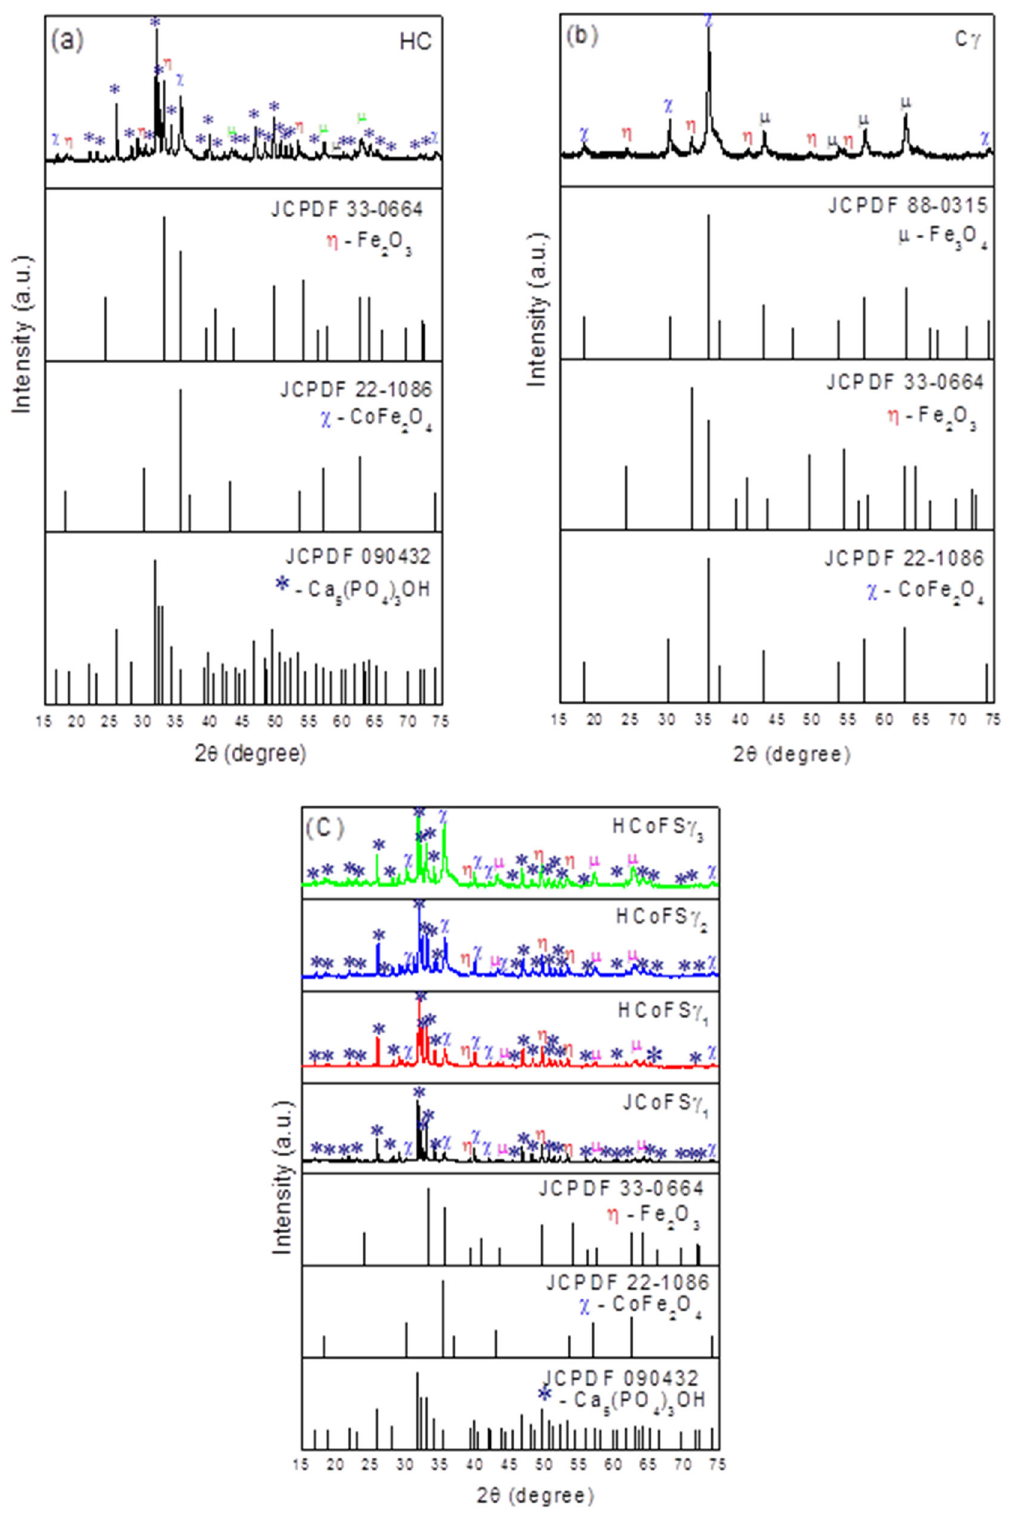
Fig. 1 X-ray diffraction (XRD) of the hybrid composites: ( a ) CoFe 2 O 4 @SiO 2 :HAp (HC); ( b ) CoFe 2 O 4 @SiO 2 : γ (C γ ); ( c ) CoFe 2 O 4 @SiO 2 :Hap (70:30) (JCoFS γ 1 ); CoFe 2 O 4 @SiO 2 :HAp (70:30)